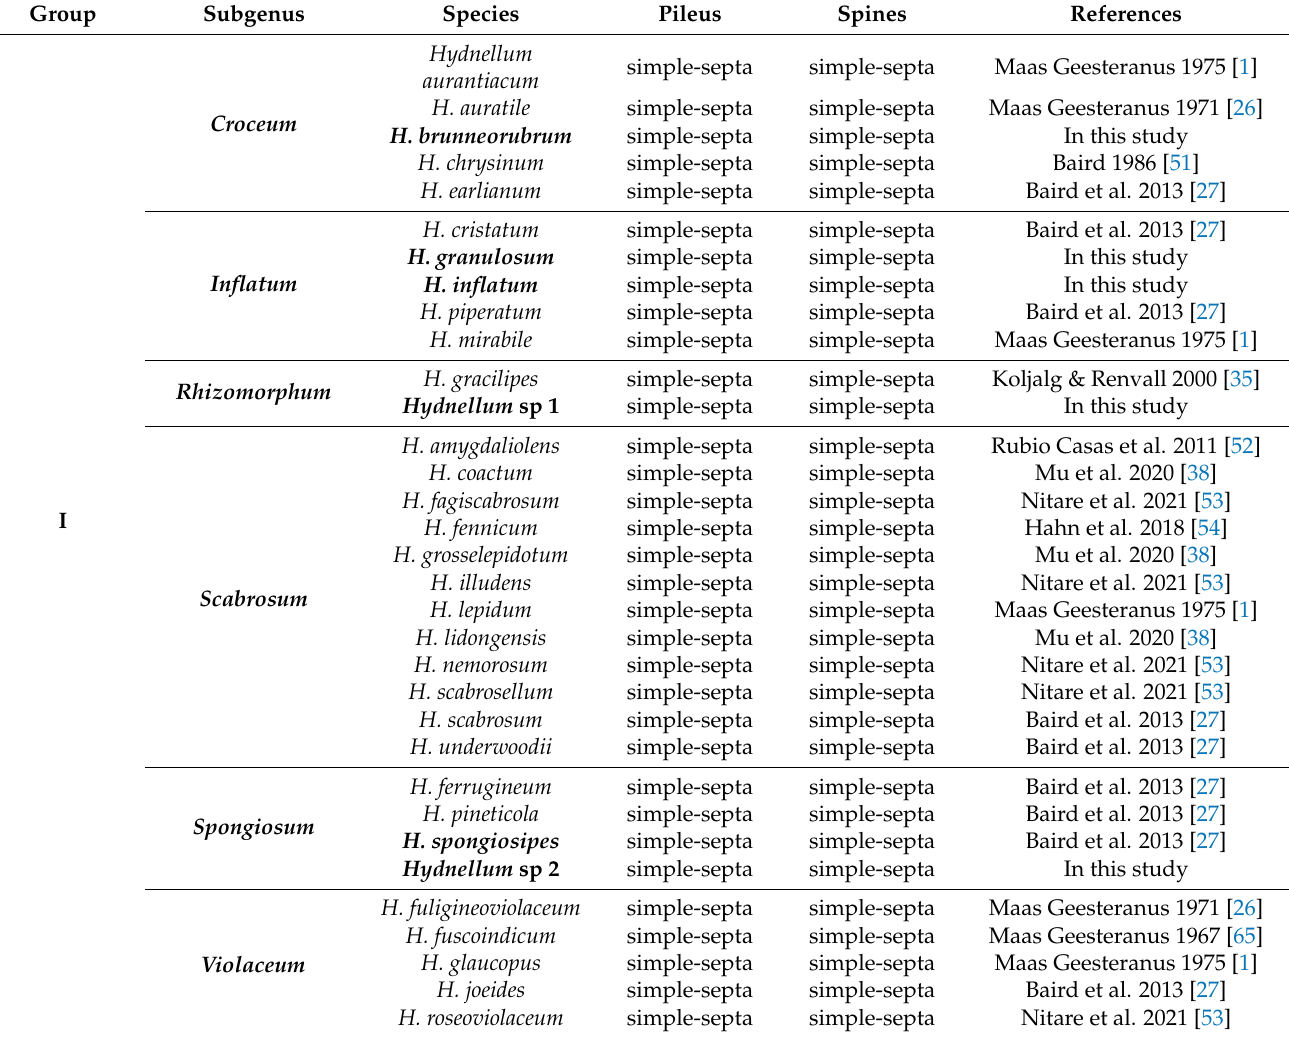
Table 3. Hyphal-septa type observations in the context of the pileus and the spine trama in the species of Hydnellum and Sarcodon .